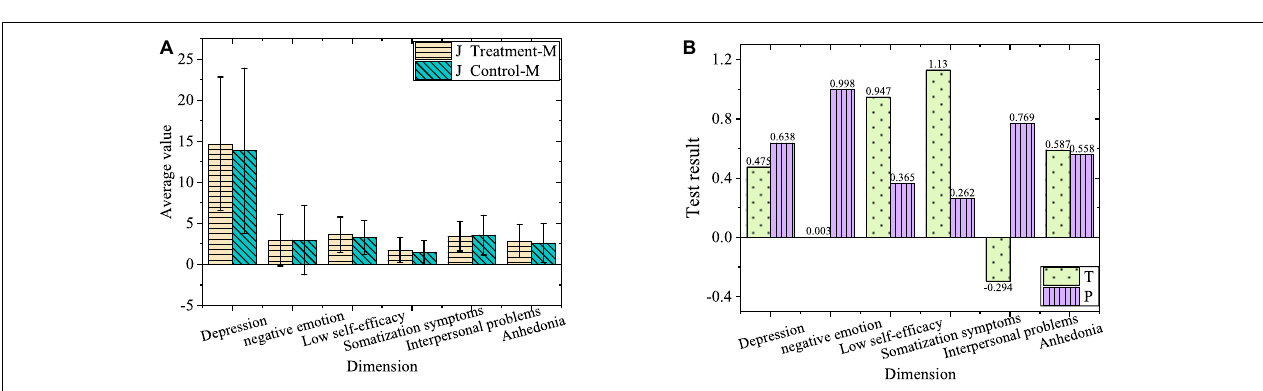
FIGURE 3 | Comparison of negative emotions of juniors. (A) Average of treatment group and control group. (B) Value of T and P of treatment group and control group.